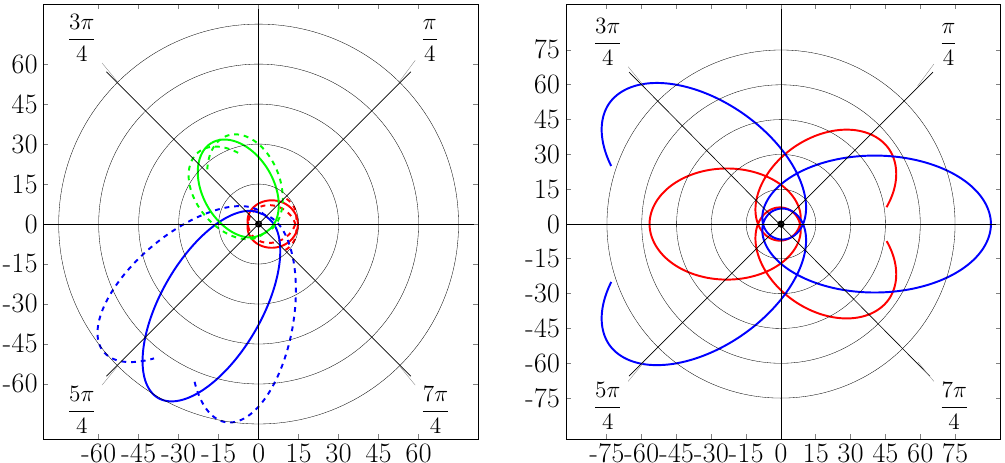
Figure 3. The shapes of some precessing trajectories of massive test particles for ansatz (28) with a = 1. Left panel ( J = 3): E 2 = 0.90, ∆ ϕ = 0.31 (red line), E 2 = 0.95, ∆ ϕ = E 2 = 0.975, ∆ ϕ = 0.36 (blue line). The dashed parts of lines represent the ’hidden’ parts of trajectories − located in the region r < 0. Right panel ( J = 4.2): E 2 = 0.97, ∆ ϕ = 2.52 (red line), E 2 = 0.98, ∆ ϕ = 2.70 (blue line).